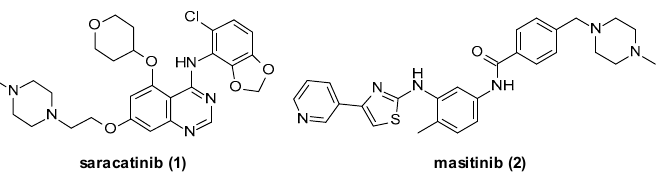
Figure 1. Chemical structures of saracatinib (1) and masitinib (2), two FYN inhibitors firstly developed for the treatment of cancer and repurposed as CNS-agents.